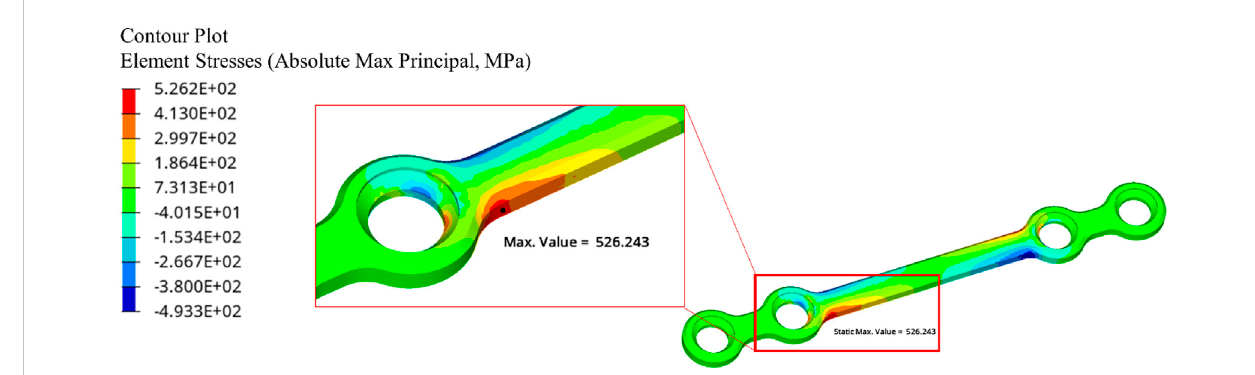
FIGURE 7 Absolute principal stress distribution and maximum location for a 35.6 N applied force.